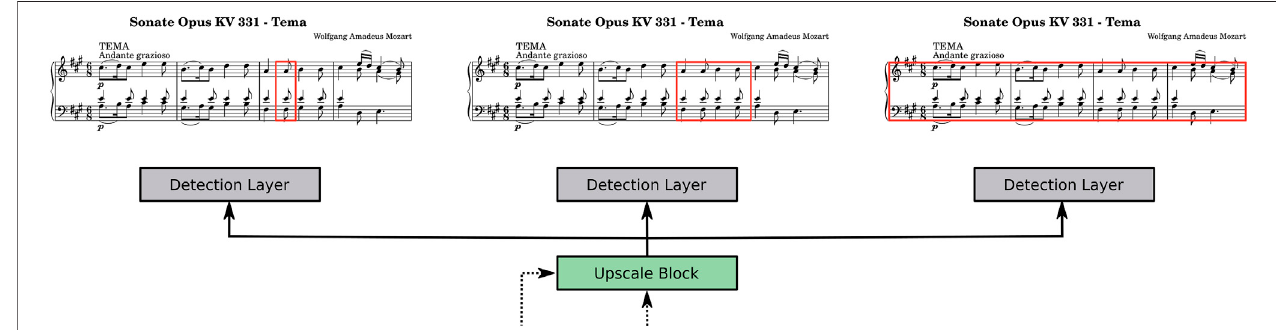
FIGURE 6 | Joint alignment prediction at several granularity levels. Each Detection layer is responsible for a speci fi c alignment type - either notes, bars or systems, andtakesthesameinputfromthelastUpscaleblockasshownin Figure4 .Notethatwhileweonlyvisualizethepredictionforanexcerptofascore,theactualprediction is based on a full